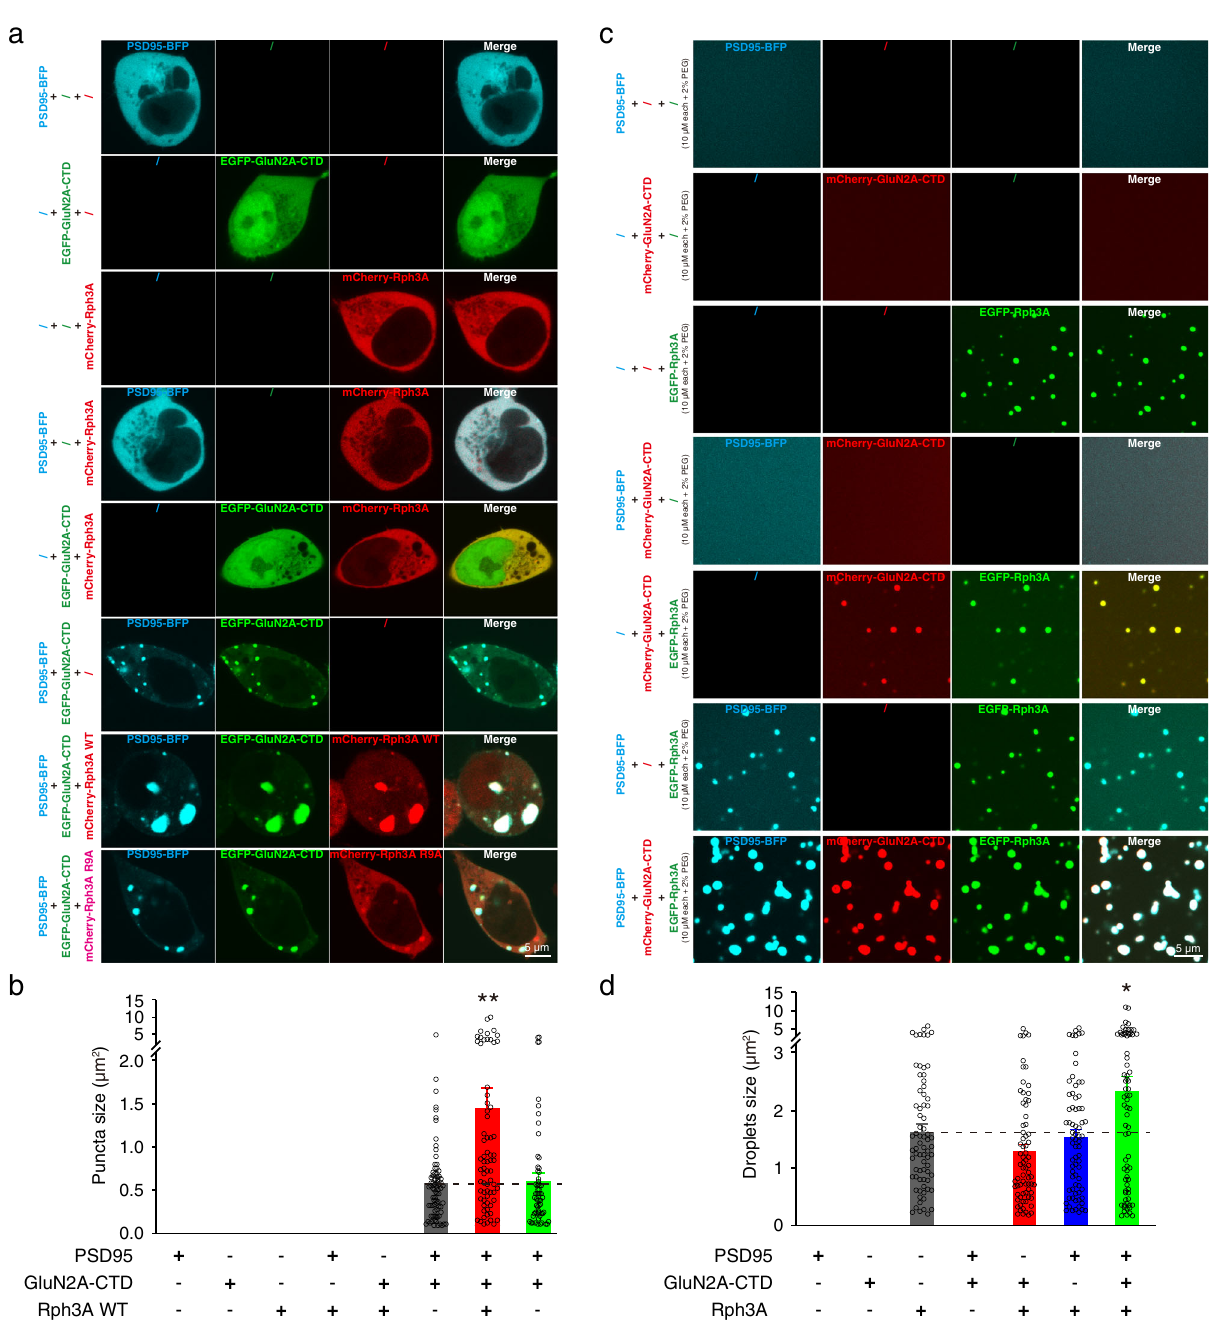
formed by different combinations of PSD95, GluN2A-CTD, WT, and R9A Rph3A recombinant fusion proteins in a cell-free system. d Sizesofdroplets composedof different combinations of proteins in c . The data are displayed as the mean±SEM ( n =73 droplets for each group, * p <0.05, one-way ANOVA followed by Tukey ’ s multiplecomparisonstest).Sourcedataand p valuesof b and d areprovidedinthe Source Data fi